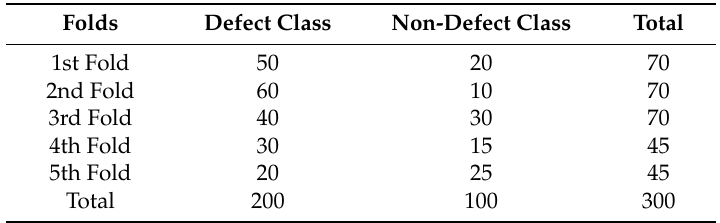
Table 3. Data samples and their distribution in